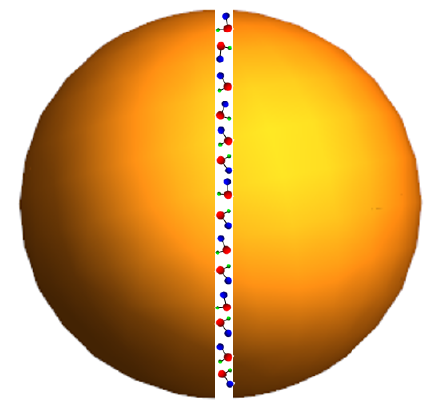
Figure 7. Slotted spherical dielectric resonator, reprinted with permission from [16], the Optical Society